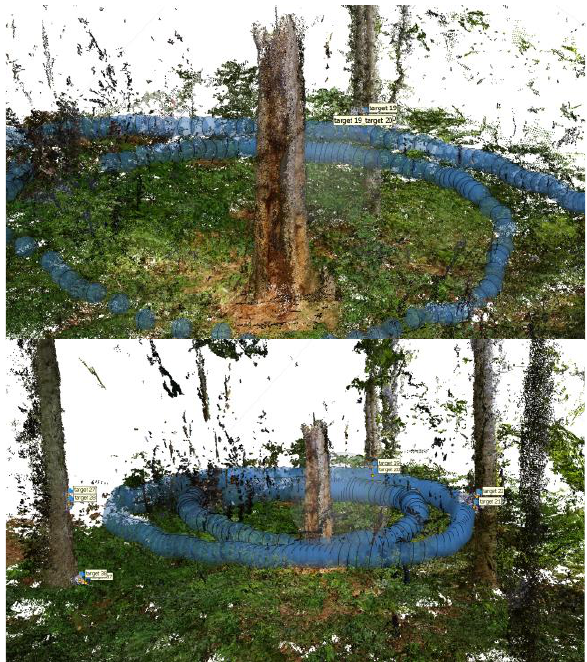
Figure 4. Dense point cloud from the 360 0 video for the studied tree (“Tree 01”) and its environment.